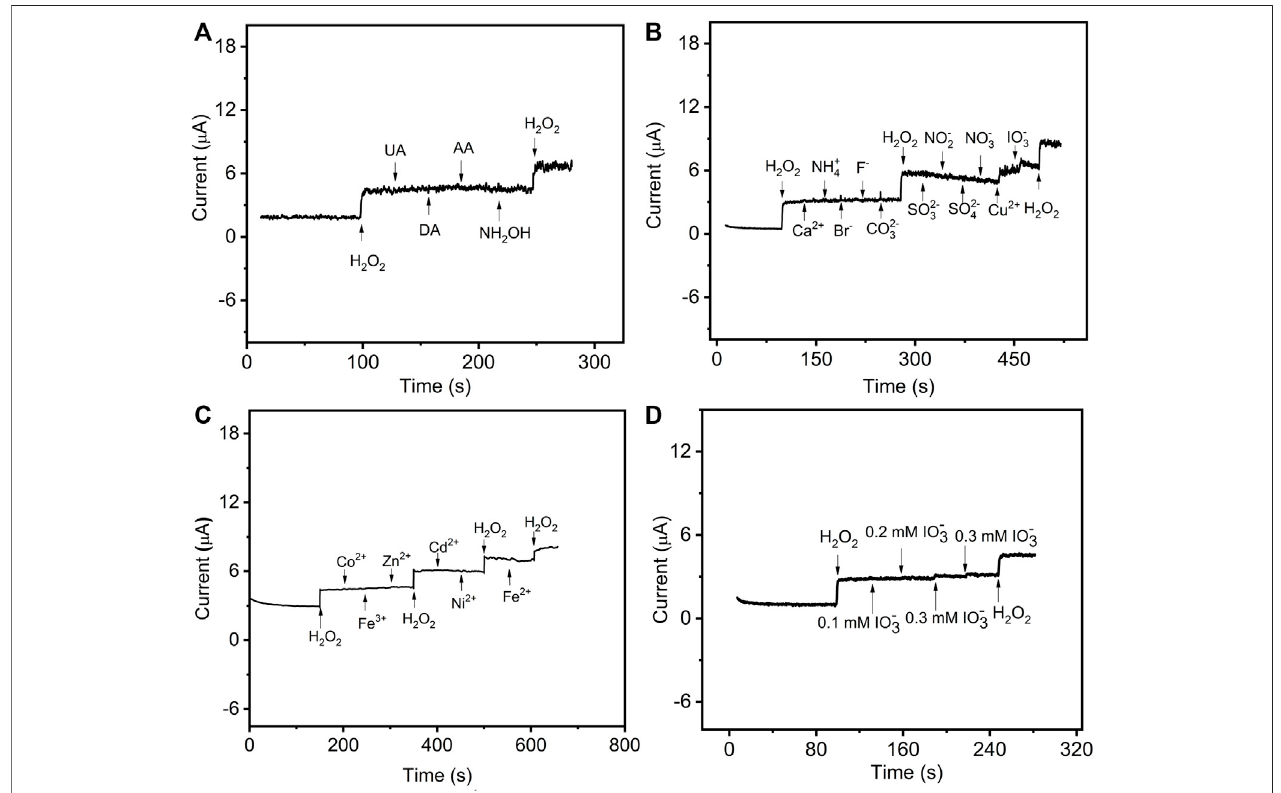
FIGURE5| Thecurrent – timecurveofGO – NMB/GCEin0.1 MstirringPBSwithsuccessiveinjectionsof (A) 0.05 mMH 2 O 2 ,0.3 mMuricacid(UA),dopamine(DA), ascorbic acid (AA), hydroxylamine hydrochloride (NH 2 OH), and 0.05 mM H 2 O 2 . (B) 0.05 mM H 2 O 2 , 0.3 mM Ca 2+ , NH 4+ , Br − , F − , CO 32 − , SO 32 − , NO 2 − , SO 42 − , NO 3 − , Cu 2+ , IO 3 − , and 0.05 mM H 2 O 2 (C) 0.05 mM H 2 O 2 and various concentrations of Cu 2+ . (D) 0.05 mM H 2 O 2 and various concentrations of IO 3 −